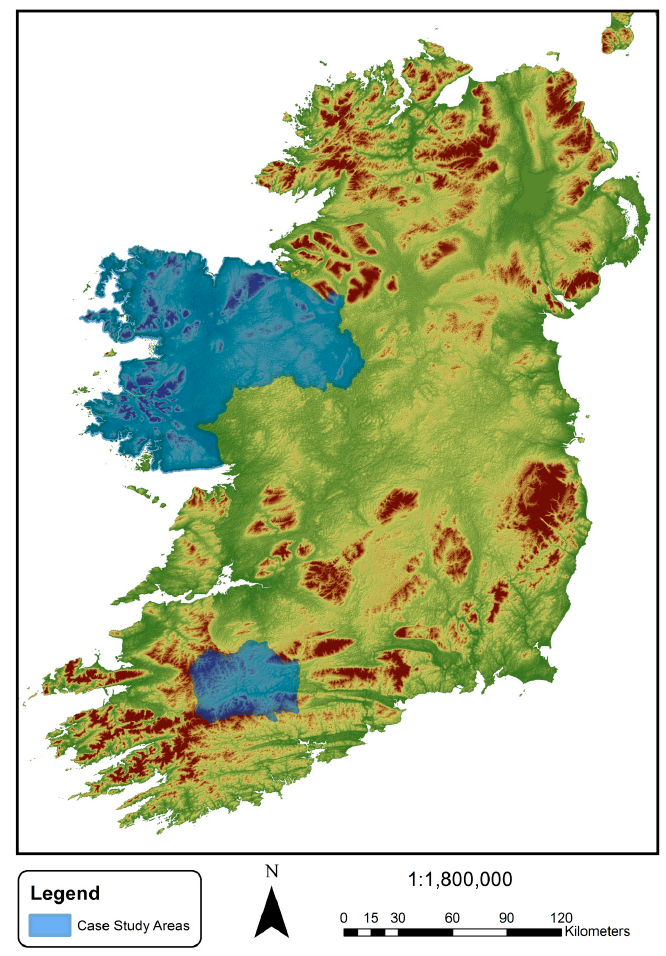
Figure 1. Location of both case study areas: Western Peatlands (top); and Newmarket (bottom).